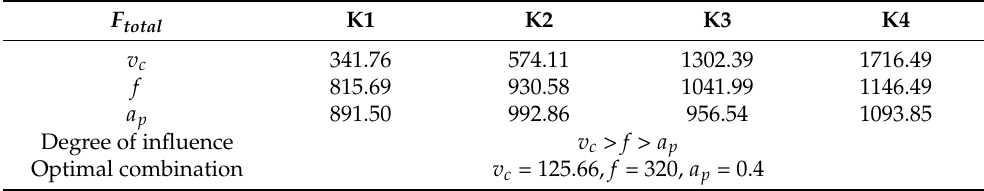
Table 5. F total range analysis